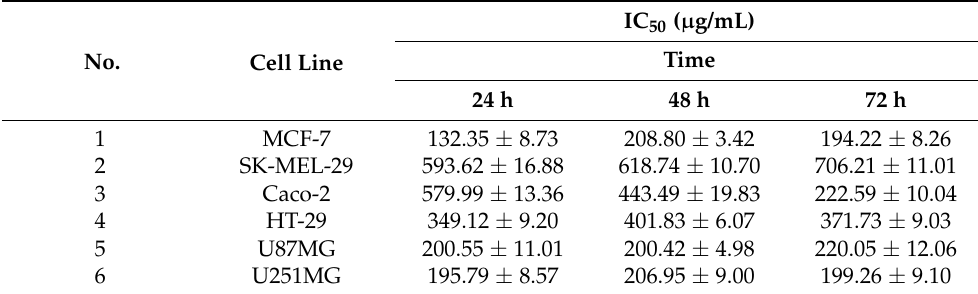
Table 4. IC 50 ( µ g/mL) values for the examined J. regia flower extracts on the viability of six human cancer cell lines after 24, 48, and 72 h of